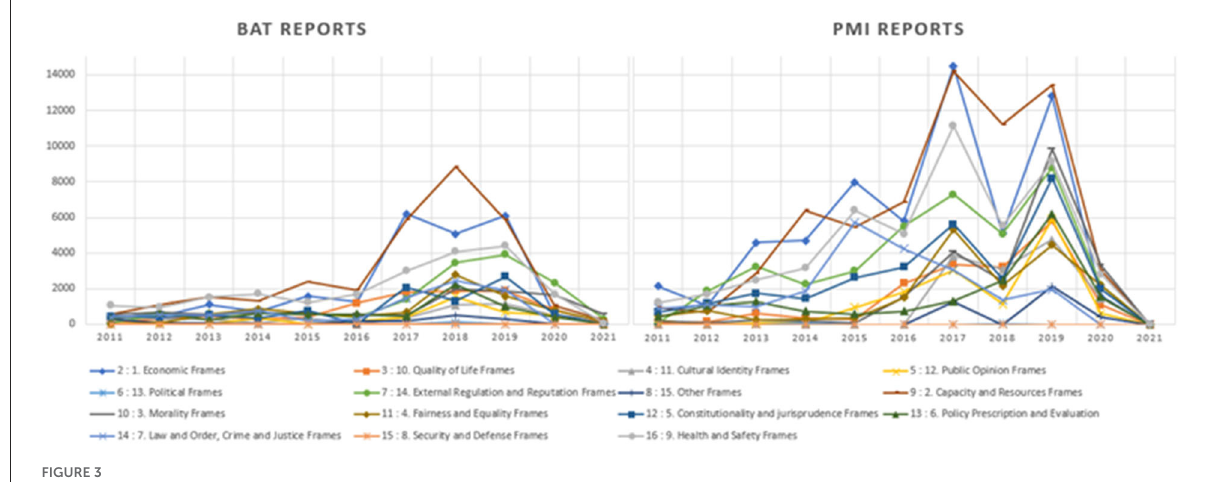
FIGURE3 Content coded to policy frames over time in BAT and PMI.